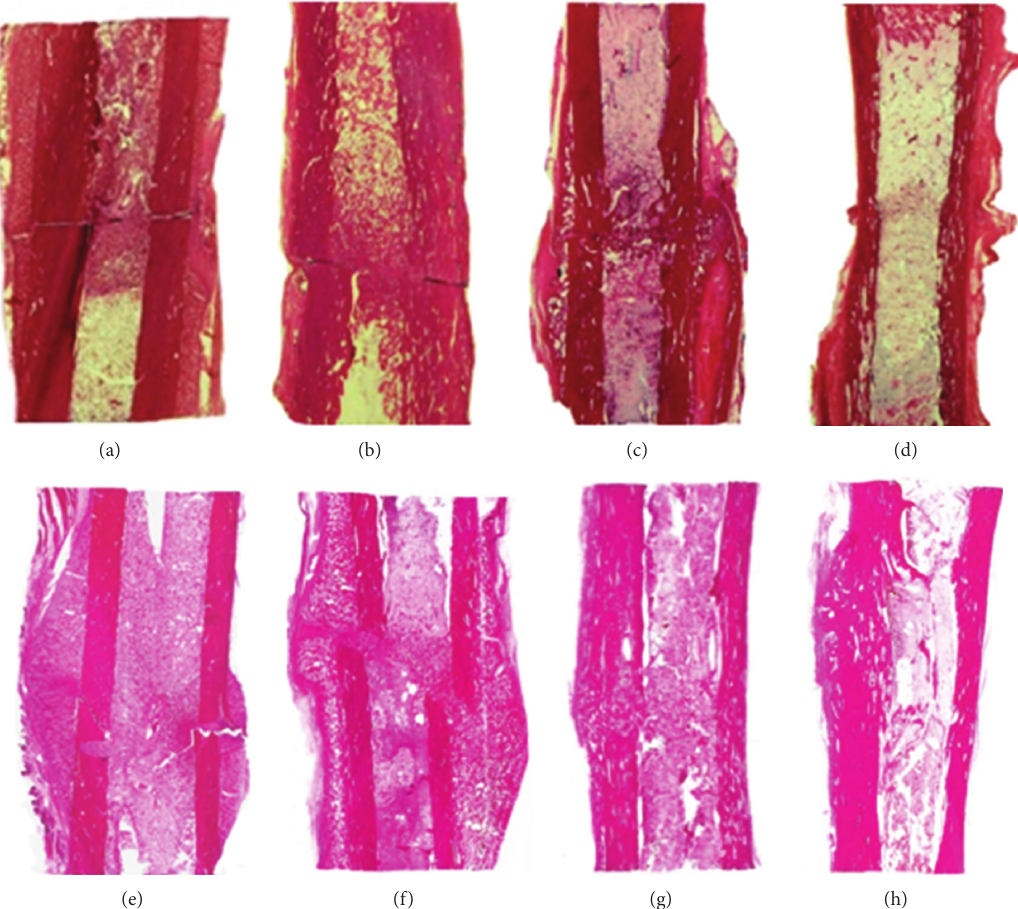
Figure 3: Tibial histotopograms. Group 1 (upper row) and group 2 (lower row): (a, e) day 14; (b, f) day 28; (c, g) day 45; and (d, h) day 75. Hematoxylin eosin staining, ×